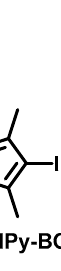
Figure 8. The structure of antiviral BODIPY derivative [111].